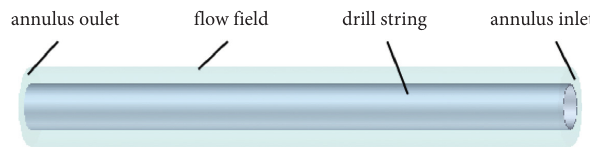
Figure 4: Finite element calculation